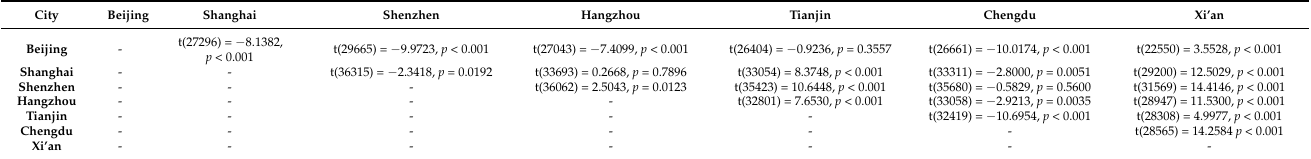
Table A2. Student’s t -test results for the seven